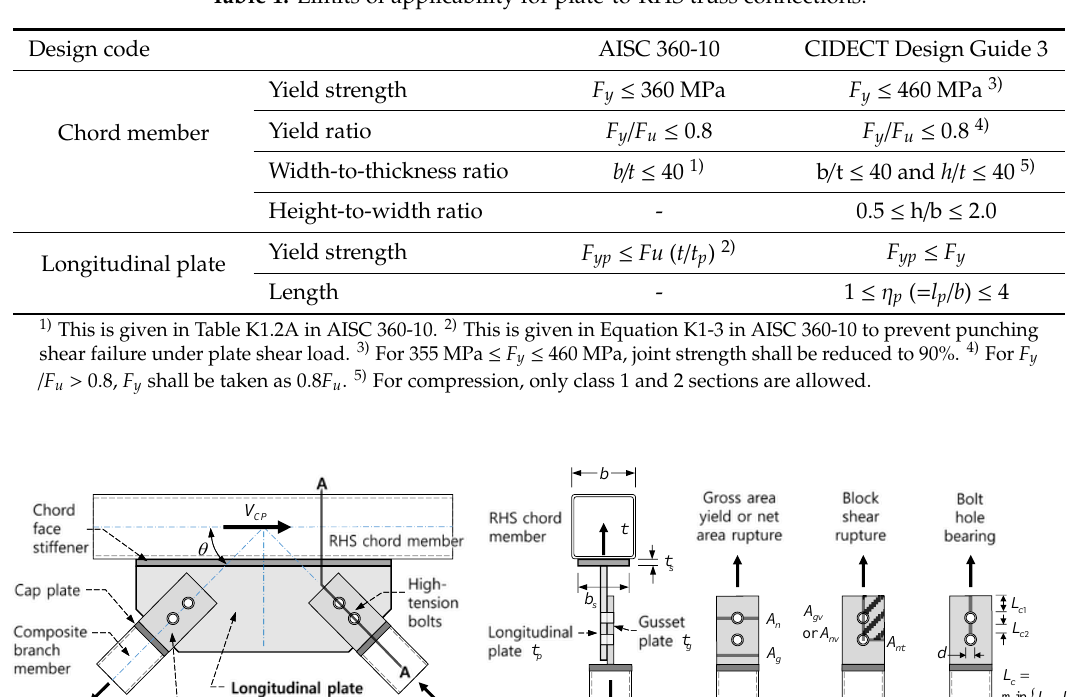
Table 1. Limits of applicability for plate-to-RHS truss connections.